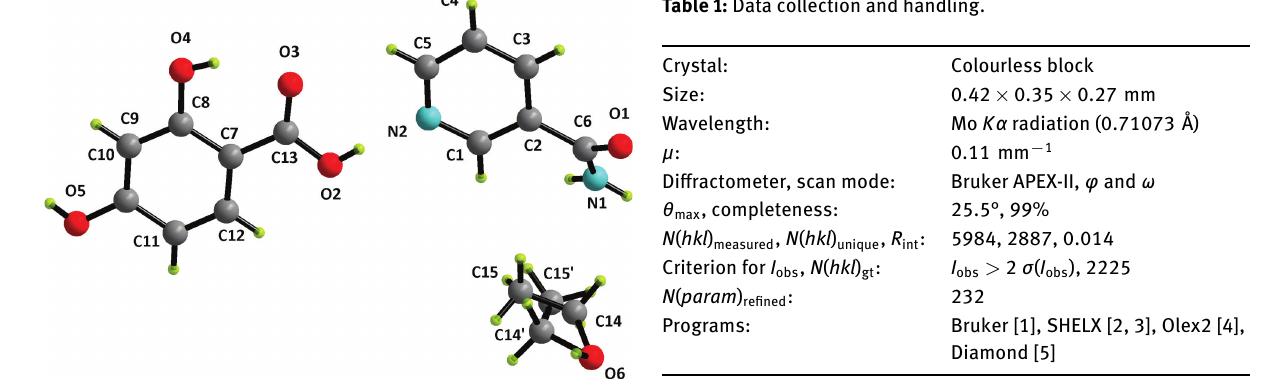
Table 1 contains crystallographic data and Table 2 contains the list of the atoms including atomic coordinates and dis- placement parameters.